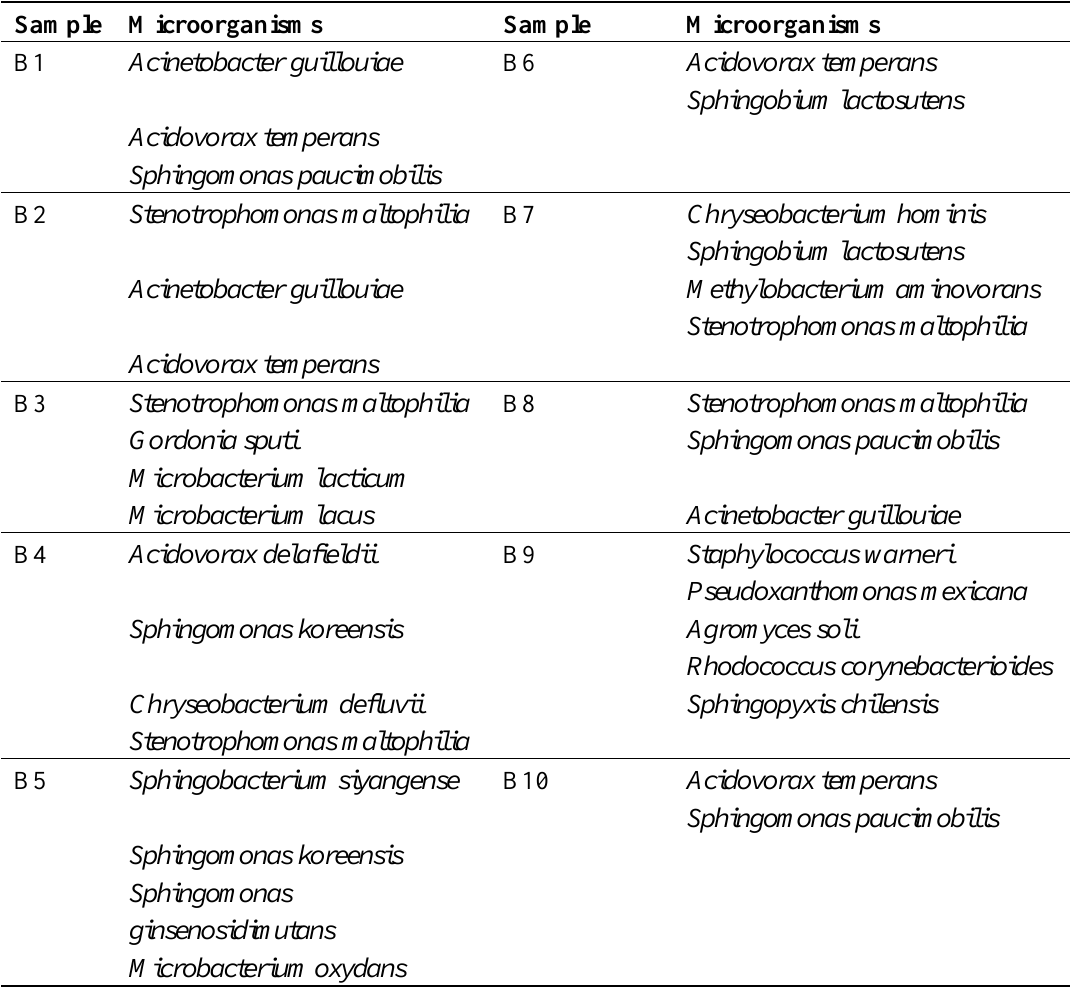
Table 3. Identification of bacteria on shower